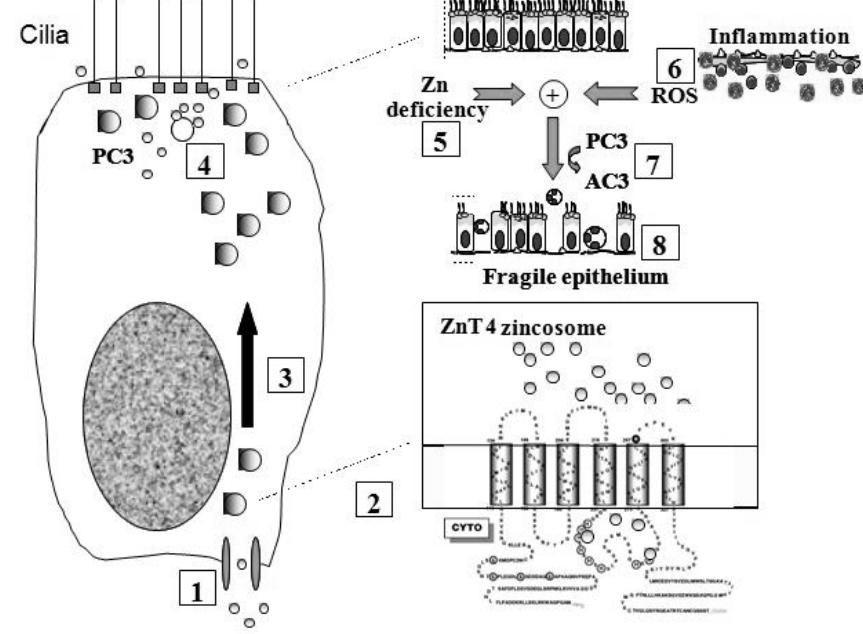
Figure 6. Model for role of ZnT4 in AE Zn homeostasis and airway inflammation: Step 1 : Zn is taken up across the basolateral plasma membrane of AEC from sub-epithelial capillaries via ZIP6 or other ZIP transporter(s); Step 2 : Zn is incorporated into vesicles with the aid of ZnT (see inset); Step 3 : These vesicles translocate to the apical cytoplasm; 4 Step 4 : Apical cellular Zn may protect the cytoplasmic mucociliary apparatus (e.g.,